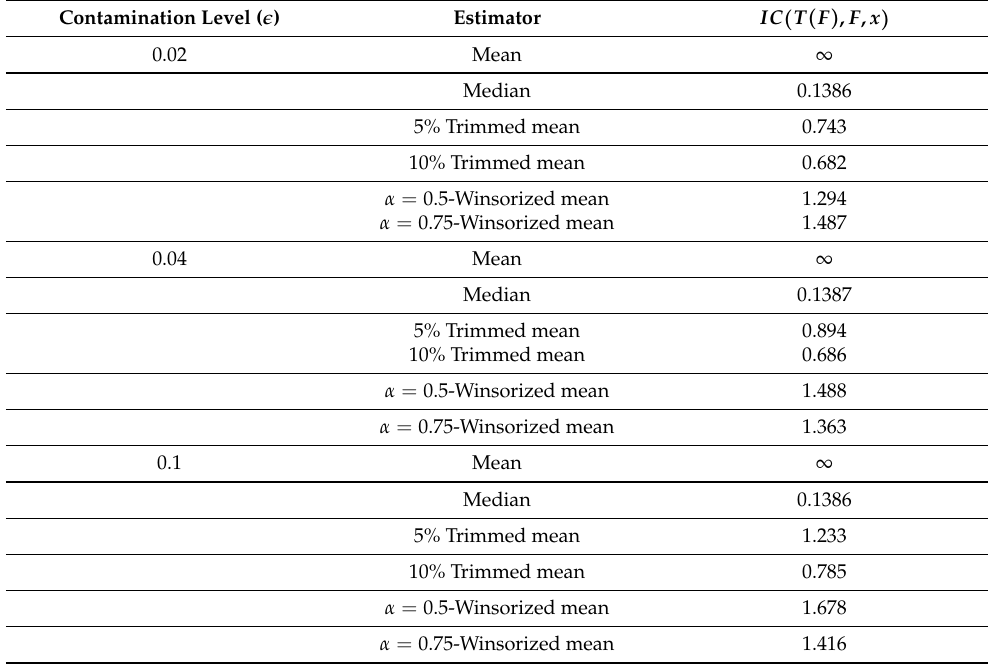
Table 1. Numerical computation of robustness of several estimators via the Influence curve. Contamination Level ( (cid:101)